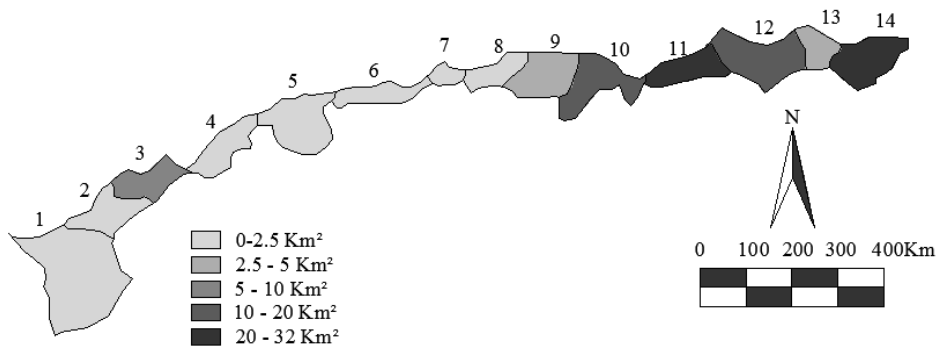
Figure 16. Development of the agriculture on the Algerian coast during 2009–2015 by department: 1—Tlemcen, 2—Ain Temouchent, 3—Oran, 4—Mostaganem, 5—Chlef, 6—Tipaza, 7—Alger, 8—Boumerdes, 9—Tizi Ouzou, 10—Béjaia, 11—Jijel, 12—Skikda, 13—Annaba, 14—El Taref. Source: made by W.H. using official data. The darker shading (in the Eastern part) indicates a better development of agriculture.